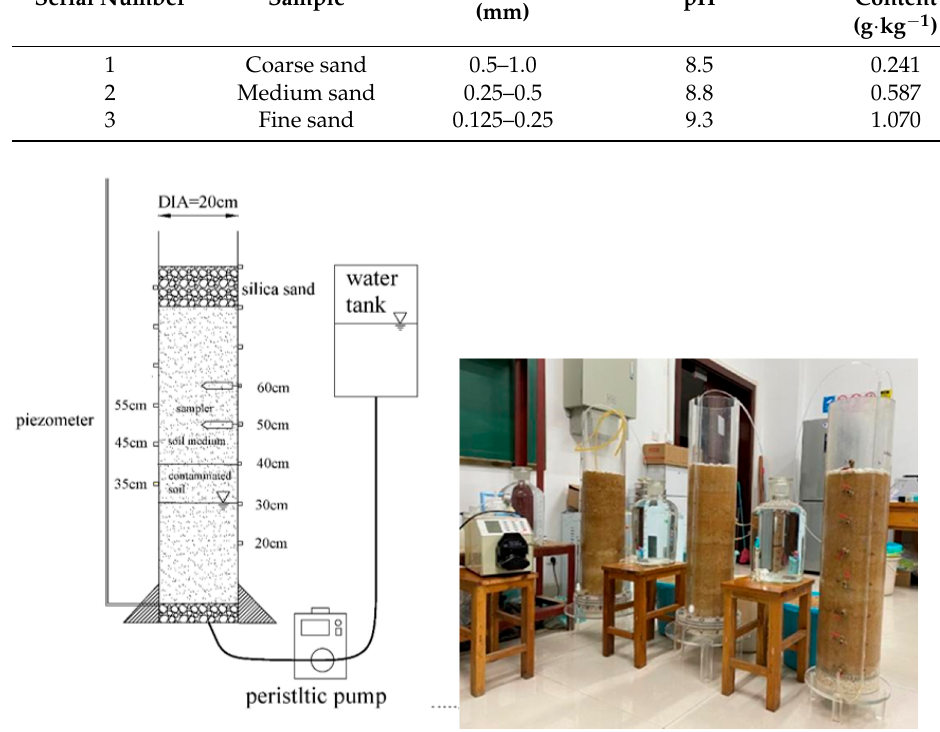
Figure 2. Schematic diagram of the experimental device.